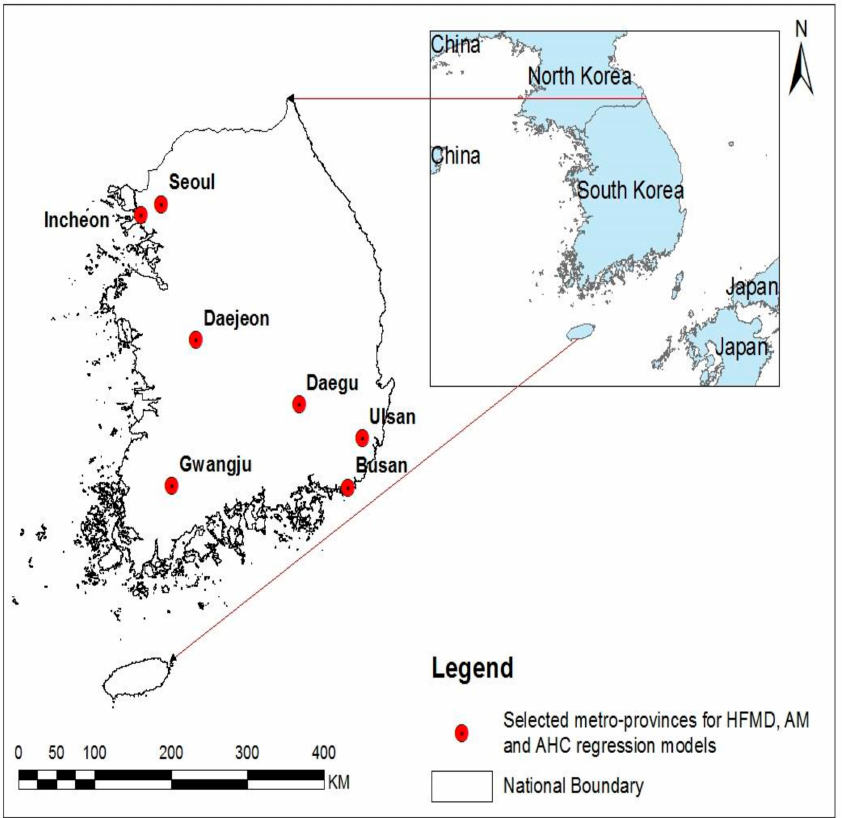
Figure 1. Map of geographical areas of Korea showing the six metropolitan provinces studied for model. The left panel shows the study sites in Korea map, and the right panel highlights the location of Korea in